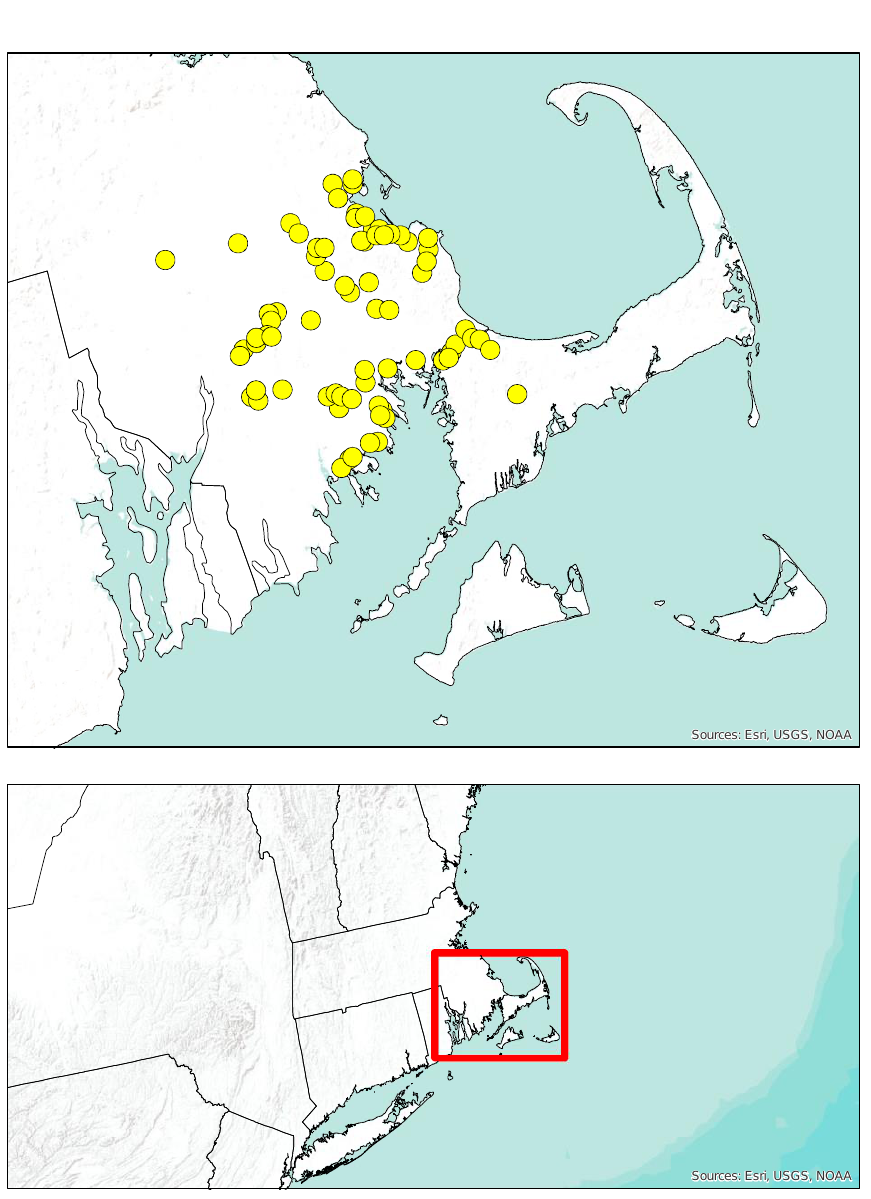
Figure 1. Map depicting collection locations (circles) of the 73 sites where Bombus workers and males were sampled across southeastern Massachusetts.